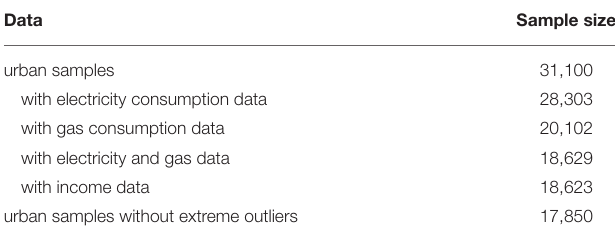
TABLE 1 | Number of samples from ENIGH 2018 (INEGI, 2019a) that correspond to urban areas and have data for electricity consumption, gas consumption, and